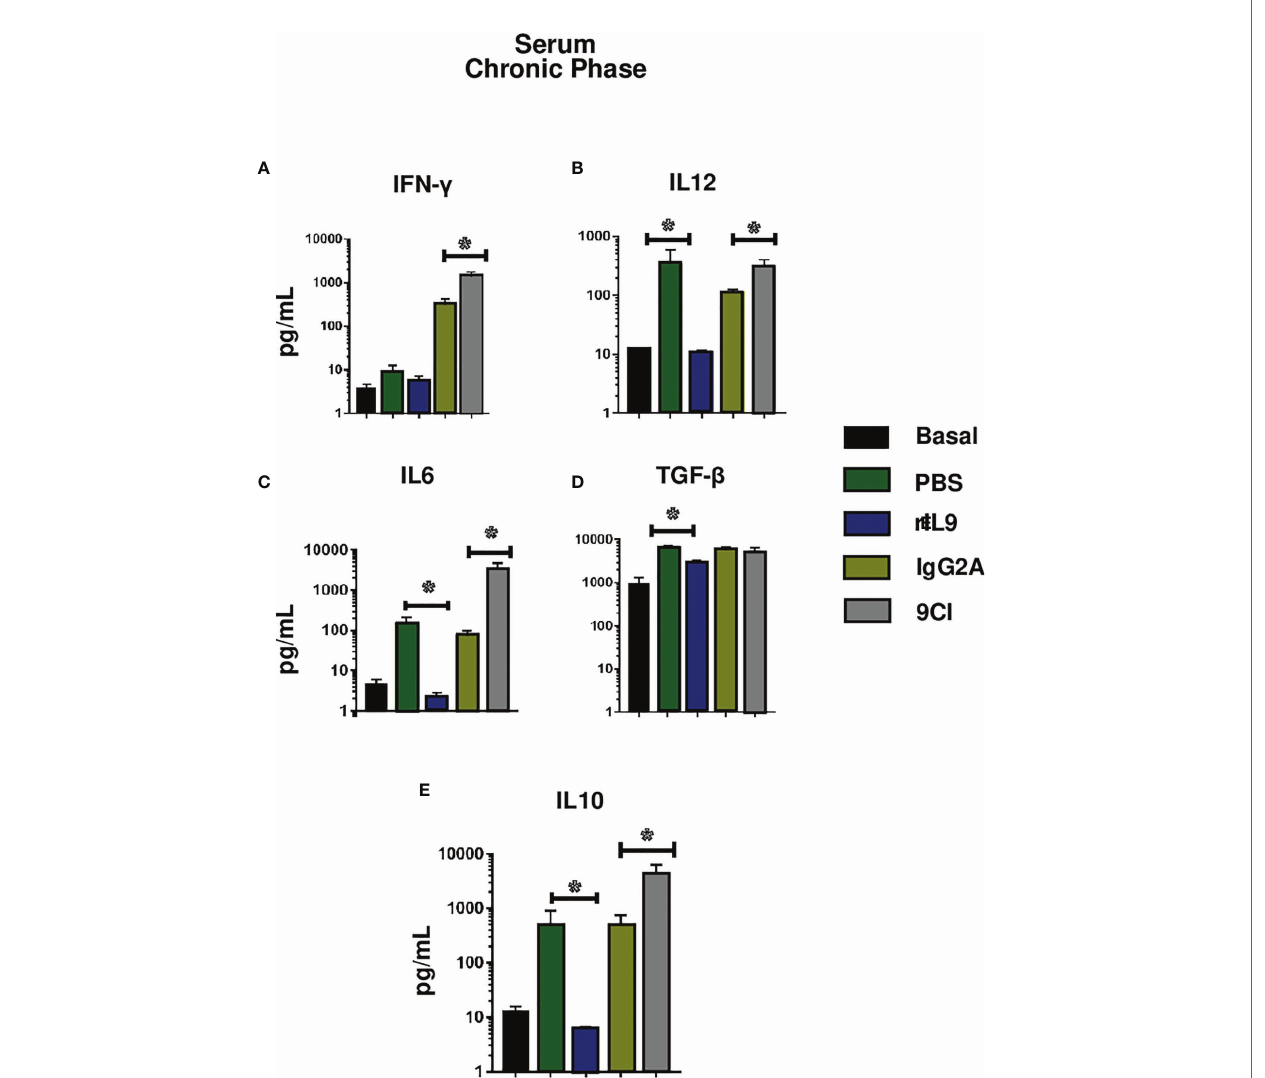
FIGURE 6 | Cytokine levels in serum from infected BALB/c mice, those treated with 9CI or rIL9, and the respective control groups. Cytokines were quanti fi ed in serum from infected mice, those treated with 9CI or rIL9, and control mice (IgG2a and PBS, respectively) after 60 dpi (chronic phase). IL-9 neutralization stimulated IFN- g (A) , IL-12 (B) IL-6 (C) , and IL-10 (E) synthesis relative to the control group (IgG2a) during chronic infection. rIL9 treatment reduced IL-6 (C) , IL-12 (B) , TGF- b (D) , and IL-10 (E) production. Anova test *p < 0.001. Basal: uninfected and untreated